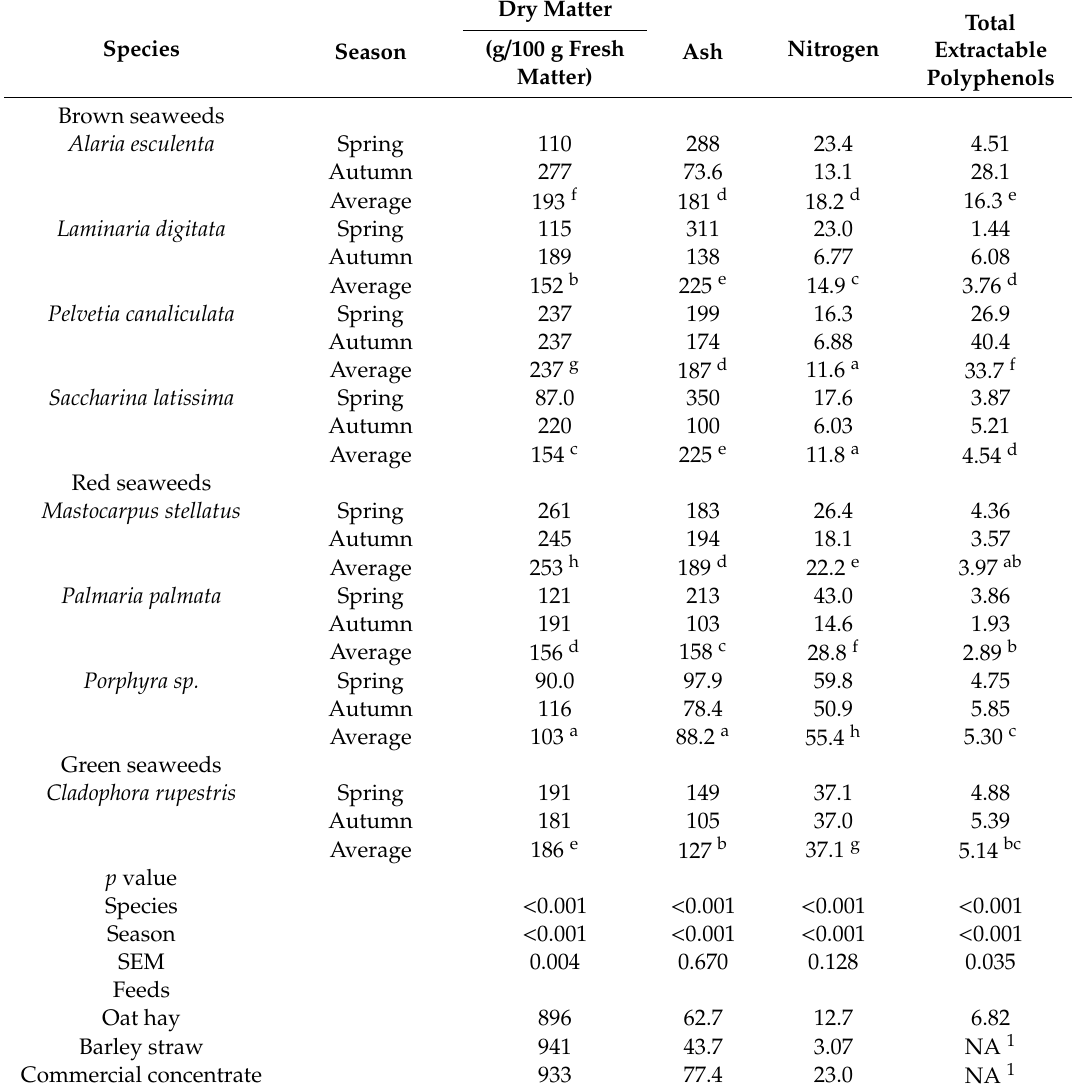
Table 2. Chemical composition (g / kg dry matter unless otherwise stated) of di ff erent seaweed species harvested in spring and autumn in northern Norway and of feeds commonly used in ruminant